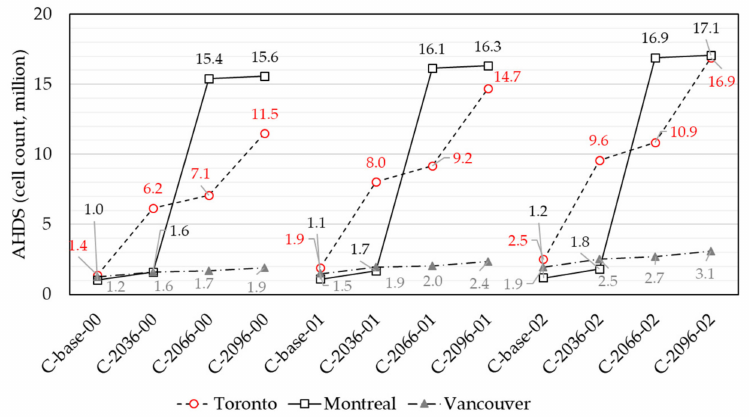
Figure 10. The total count of cells with HHI greater than the mean HHI for Toronto, Montreal, and Vancouver.